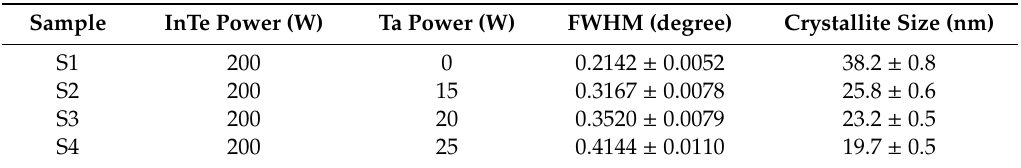
Table 1. Preparation parameters and the variations of the full width at half maximum (FWHM) and crystallite